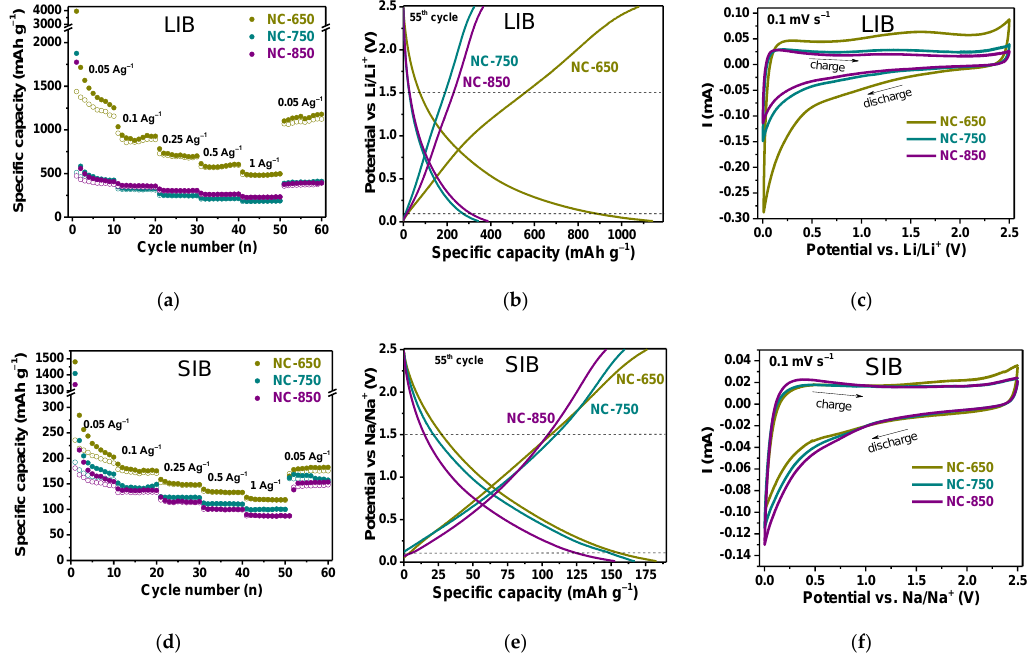
Figure 5. Electrochemical performances of NC-650, NC-750, and NC-850 in lithium-ion batteries ( upper ) and sodium-ion batteries ( down ): ( a , d ) rate capability at current densities of 0.05 – 1.00 A·g – 1 ; ( b , e ) discharge – charge curves in 55th cycles at 0.05 A·g −1 ; and ( c , f ) CV curves measured at 0.1 mV·s – 1 . CV measurements were carried out after the completion of 60 cycles at a scan rate of 0.1 mV·s ‒1 (Figure 5c,f). The CV curves of the NC samples have a similar shape, which is typical for carbon materials. The quasi-rectangular shape of the CV curves indicates the capacitive behavior of the NC materials. The redox peaks at ca. 0.1/0.2 V vs. Li/Li + or Na/Na + are attributed to the intercalation/extraction of lithium or sodium between gra- phitic layers. Wide peaks at 0.7/1.8 V vs. Li/Li + or Na/Na + can be associated with the reac- tion of alkali-metal ions with oxygen- or nitrogen-containing functional groups [53]. Among all the electrodes, NC-650 has a CV shape closer to a rectangular shape and the most intensive peaks at 0.1/0.2 and 0.7/1.8 V. In addition, NC-650 in LIBs shows the largest area limited by the CV curve, implying the best charge storage performance. This result is directly related to the specific surface of the material and the pore volume, which di- rectly affect the number of electrochemically active centers and the accumulation of Li + ions rather than Na + ions. The samples synthesized at higher temperatures have lower numbers of these active centers for alkaline metal adsorption sites than NC-650. Obvi- ously, the NC-650 material has excellent capability, reversibility, and stability in both LIBs and SIBs. Since NC-650 demonstrates excellent performance in both LIBs and SIBs, the electro- chemical kinetics of the NC-650 electrode with respect to lithium and sodium ion electro- chemical storage were examined using CV measurements at various scanning rates from 0.1 to 1.0 mV·s −1 (Figure 6a,c). The contribution of pseudocapacitive behavior and diffu- sion-controlled processes to the electrochemical storage process could be quantitatively estimated through the following equation : i ( v ) = k 1 v + k 2 v 1/2 , where i ( v ) is the total current,